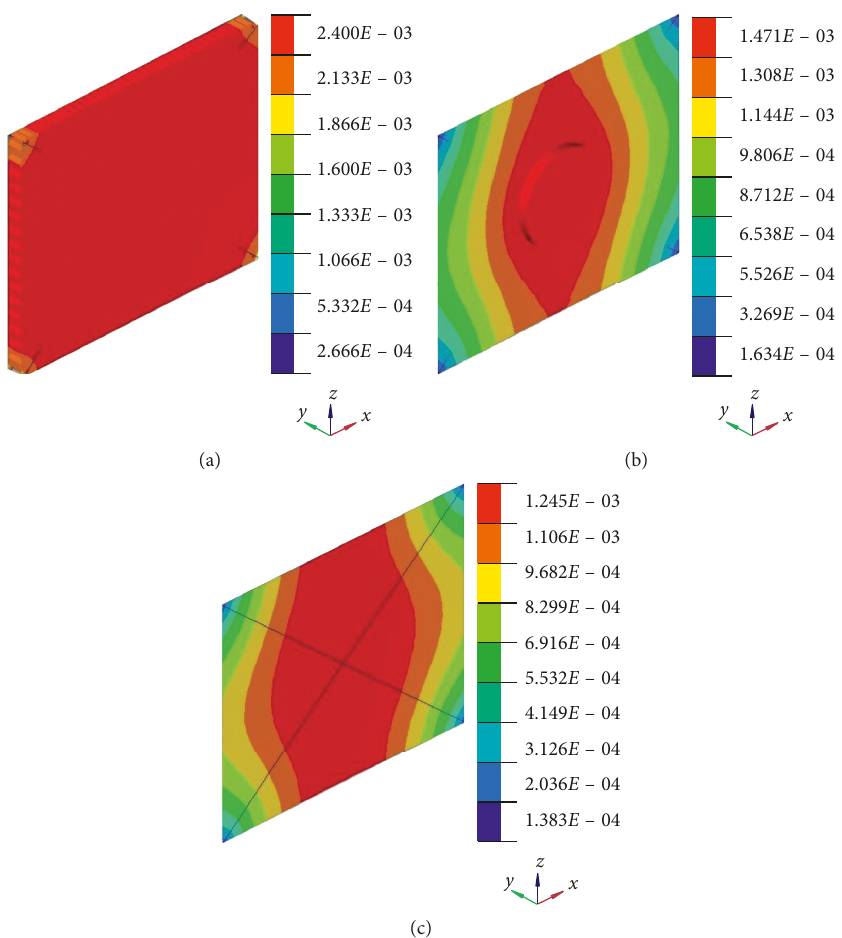
Figure 11: Displacement obtained through shock spectrum analysis. (a) Whole entity modeling, (b) equivalent plate, and (c) multilayered equivalent.